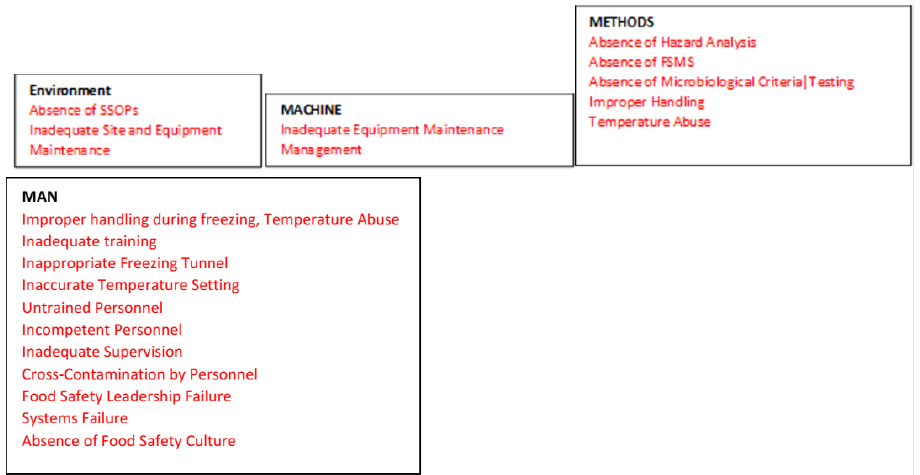
Figure 4. Fishbone diagram for problems during